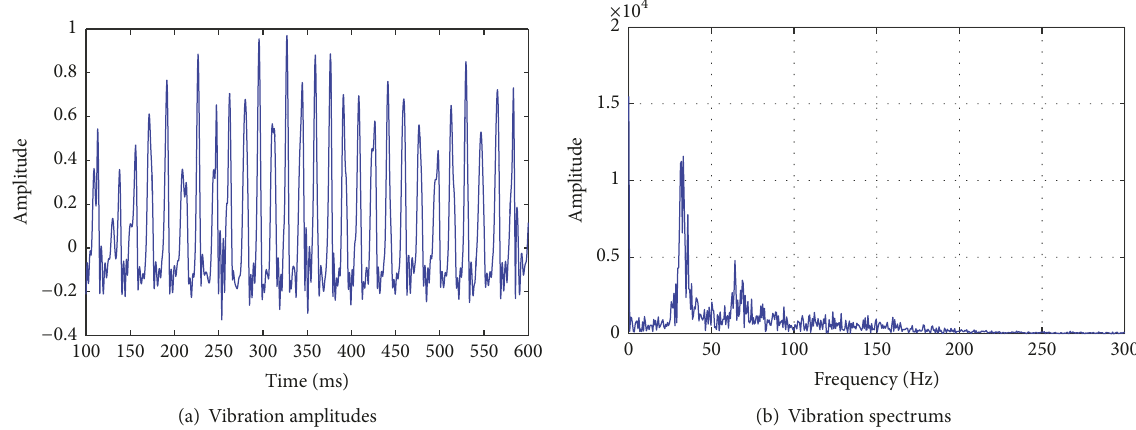
Figure 12: The horizontal direction response of the position of pedestal looseness ( 𝜆 = 0.1 , 𝛿 = 0.0001